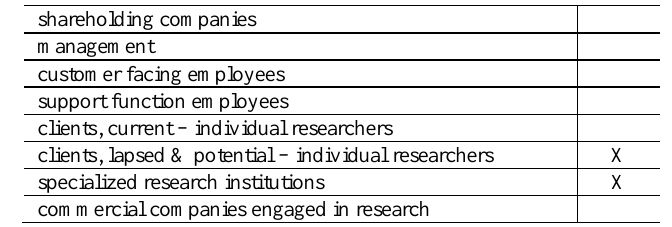
Table 8: Participants loading on Factor 5